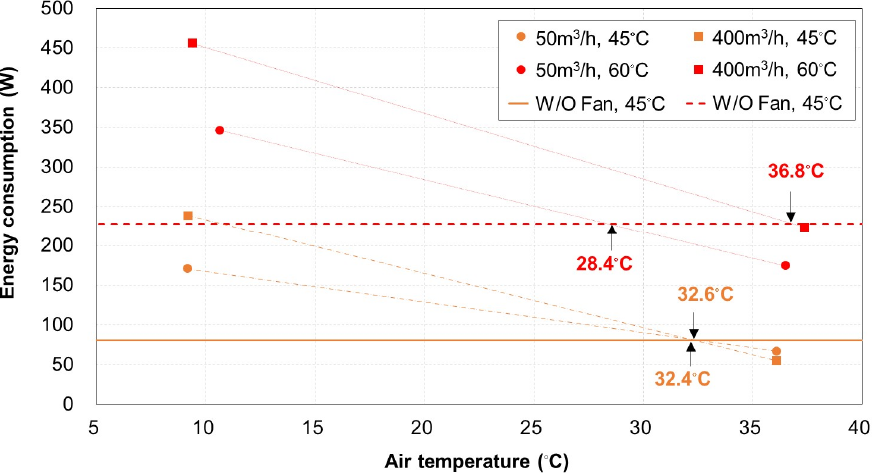
Figure 8. Energy consumption of the TERP in the heating mode according to the volume flow rate and temperature of air.